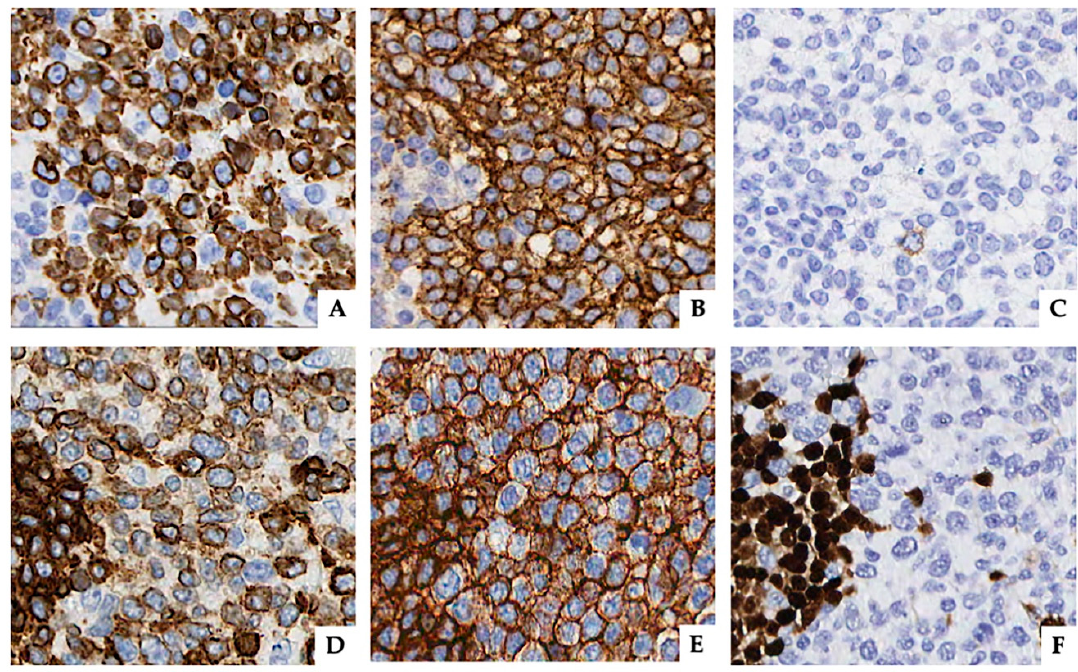
Figure 2. Pattern of immunohistochemical expression of different markers on neoplastic lymphocytes. Cytoplasmic and membrane staining were observed for CD3 ( A ) and CD79a ( D ). Membrane positivity was more evident for CD4 ( B ) and CD20 ( E ). PAX5 stained only nuclei of B cells ( F ), whereas < 1%